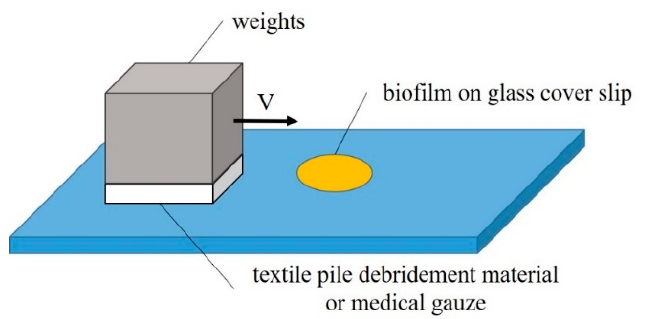
Figure 3. Experiment setup of the in vitro removal of biofilm.